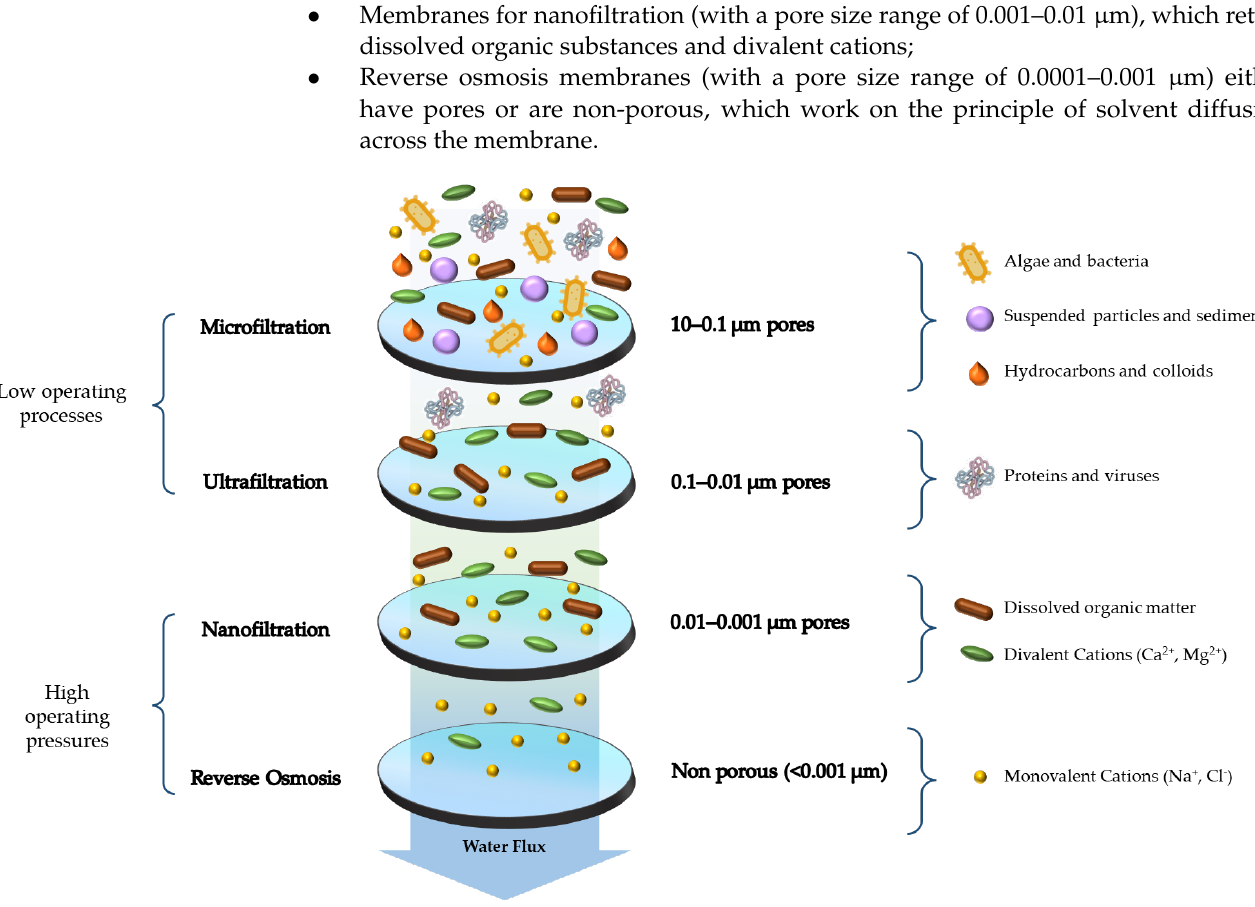
Figure 1. Schematization of dead-end ( a ) and cross-flow ( b ) filtration processes.